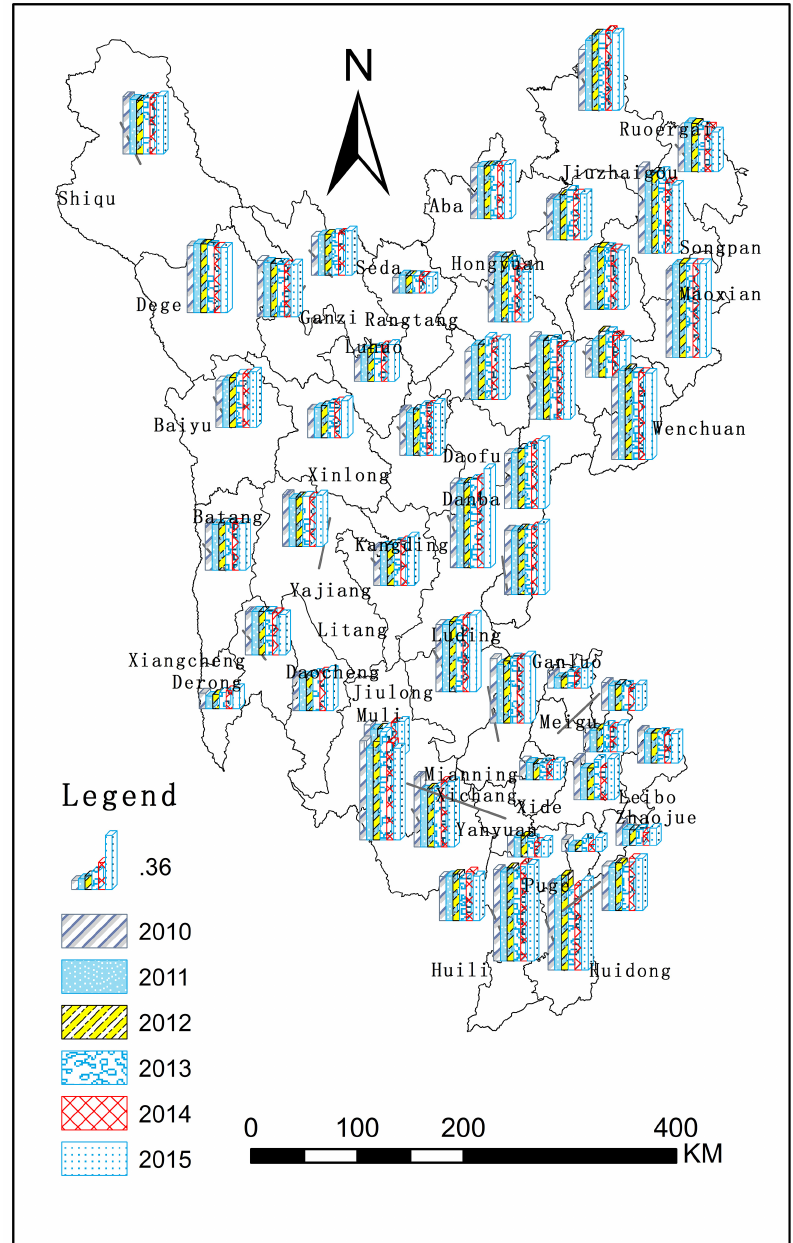
Figure 9. The total amount of livelihood